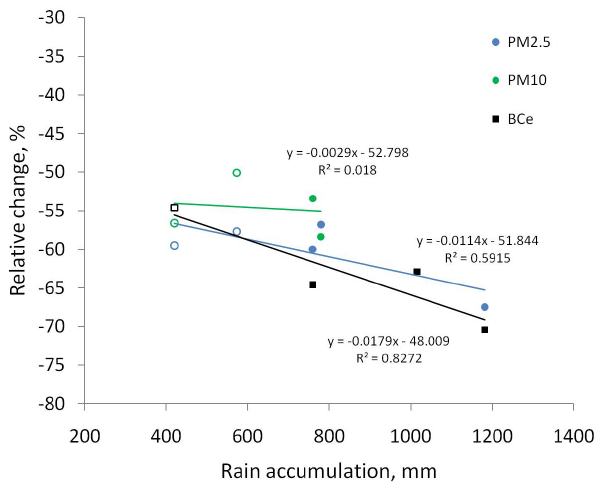
Fig. 5. The relative change of the aerosol mass concentrations from the pre-monsoon to monsoon season as a function of the June– September rain accumulation. Solid symbols: data from Muktesh- war; open symbols: data from Gual